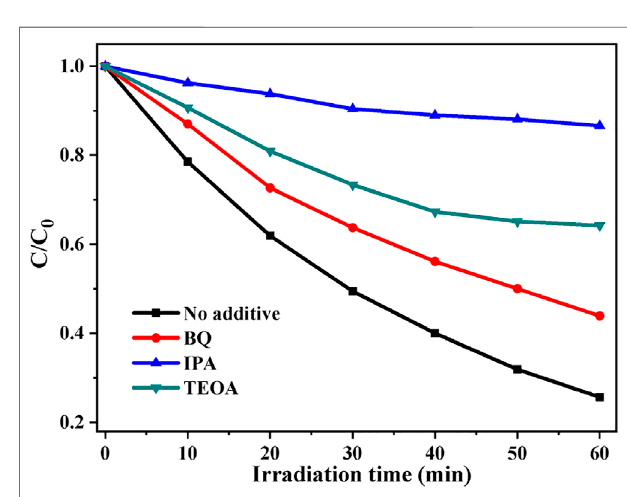
FIGURE 6 | Repeated uses of CdS/MCC-10% in the photocatalytic degradation of MB.